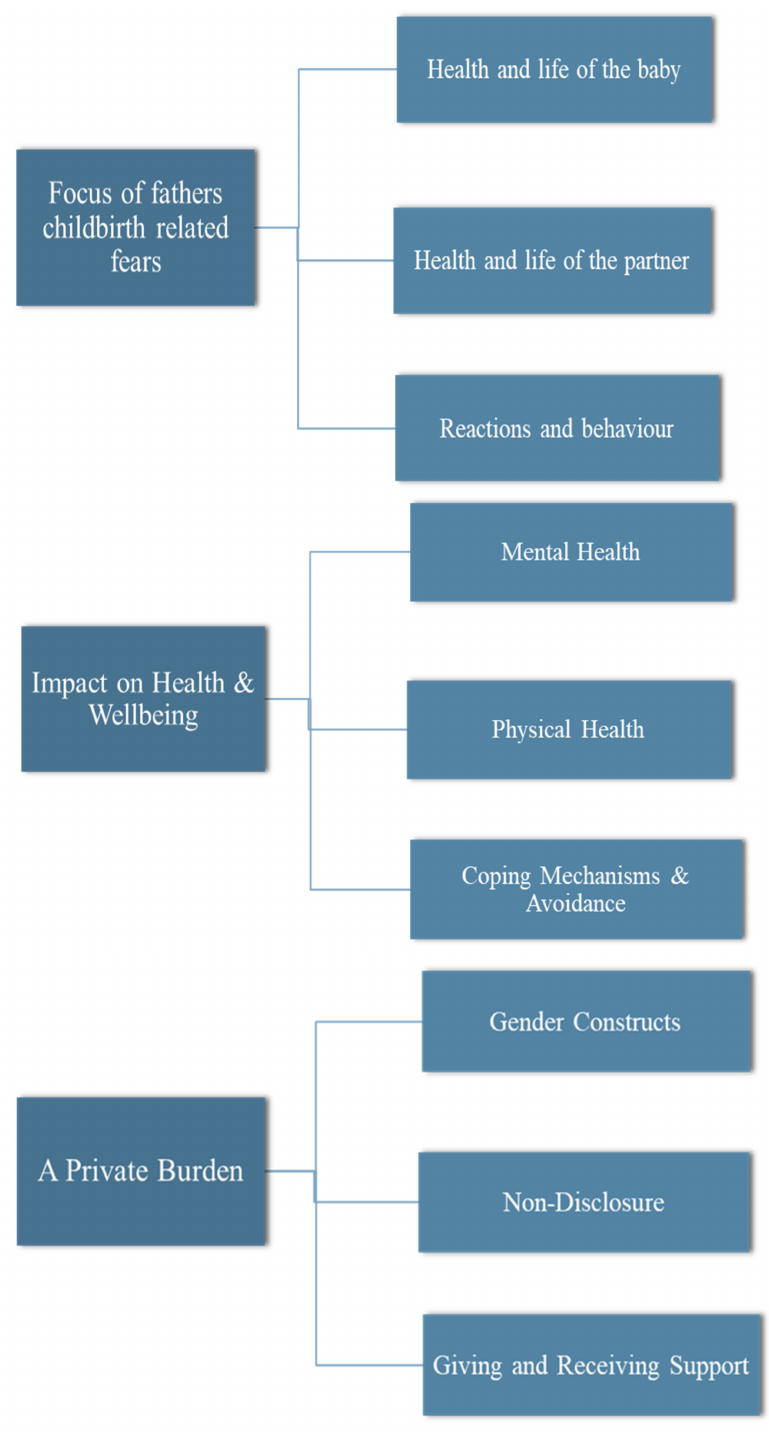
Figure 2. Themes and